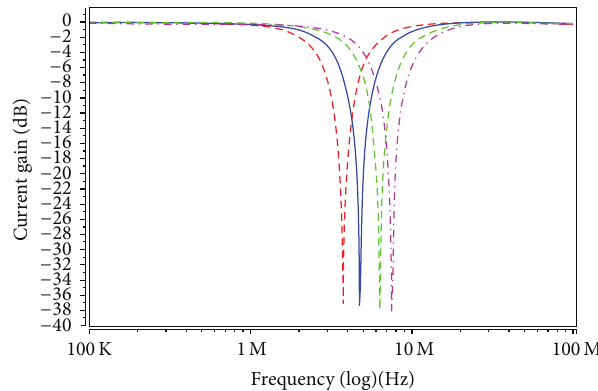
Figure 8: Electronic tunable of the BR frequency responses current- mode filter ( 𝑉 𝐶1 = 𝑉 𝐶2 = 𝑉 𝐶3 = 0.95 V: red; 𝑉 𝐶1 = 𝑉 𝐶2 = 𝑉 𝐶3 = 1 V: blue; 𝑉 𝐶1 = 𝑉 𝐶2 = 𝑉 𝐶3 = 1.1 V: green; and 𝑉 𝐶1 = 𝑉 𝐶2 = 𝑉 𝐶3 = 1.2 V: pink).